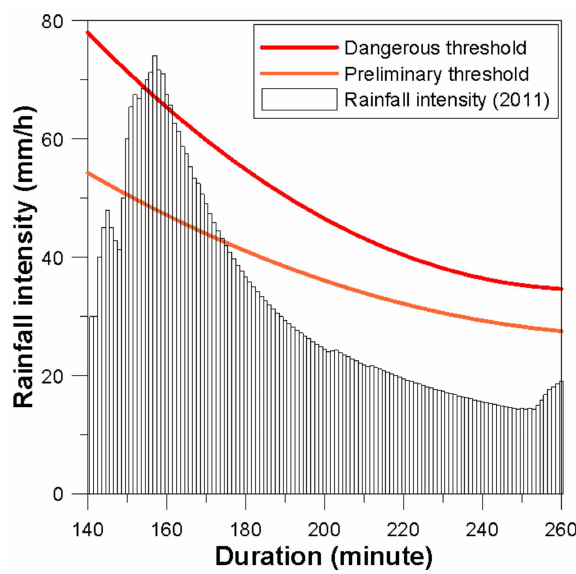
Figure 7. Application of the historical rainfall event in